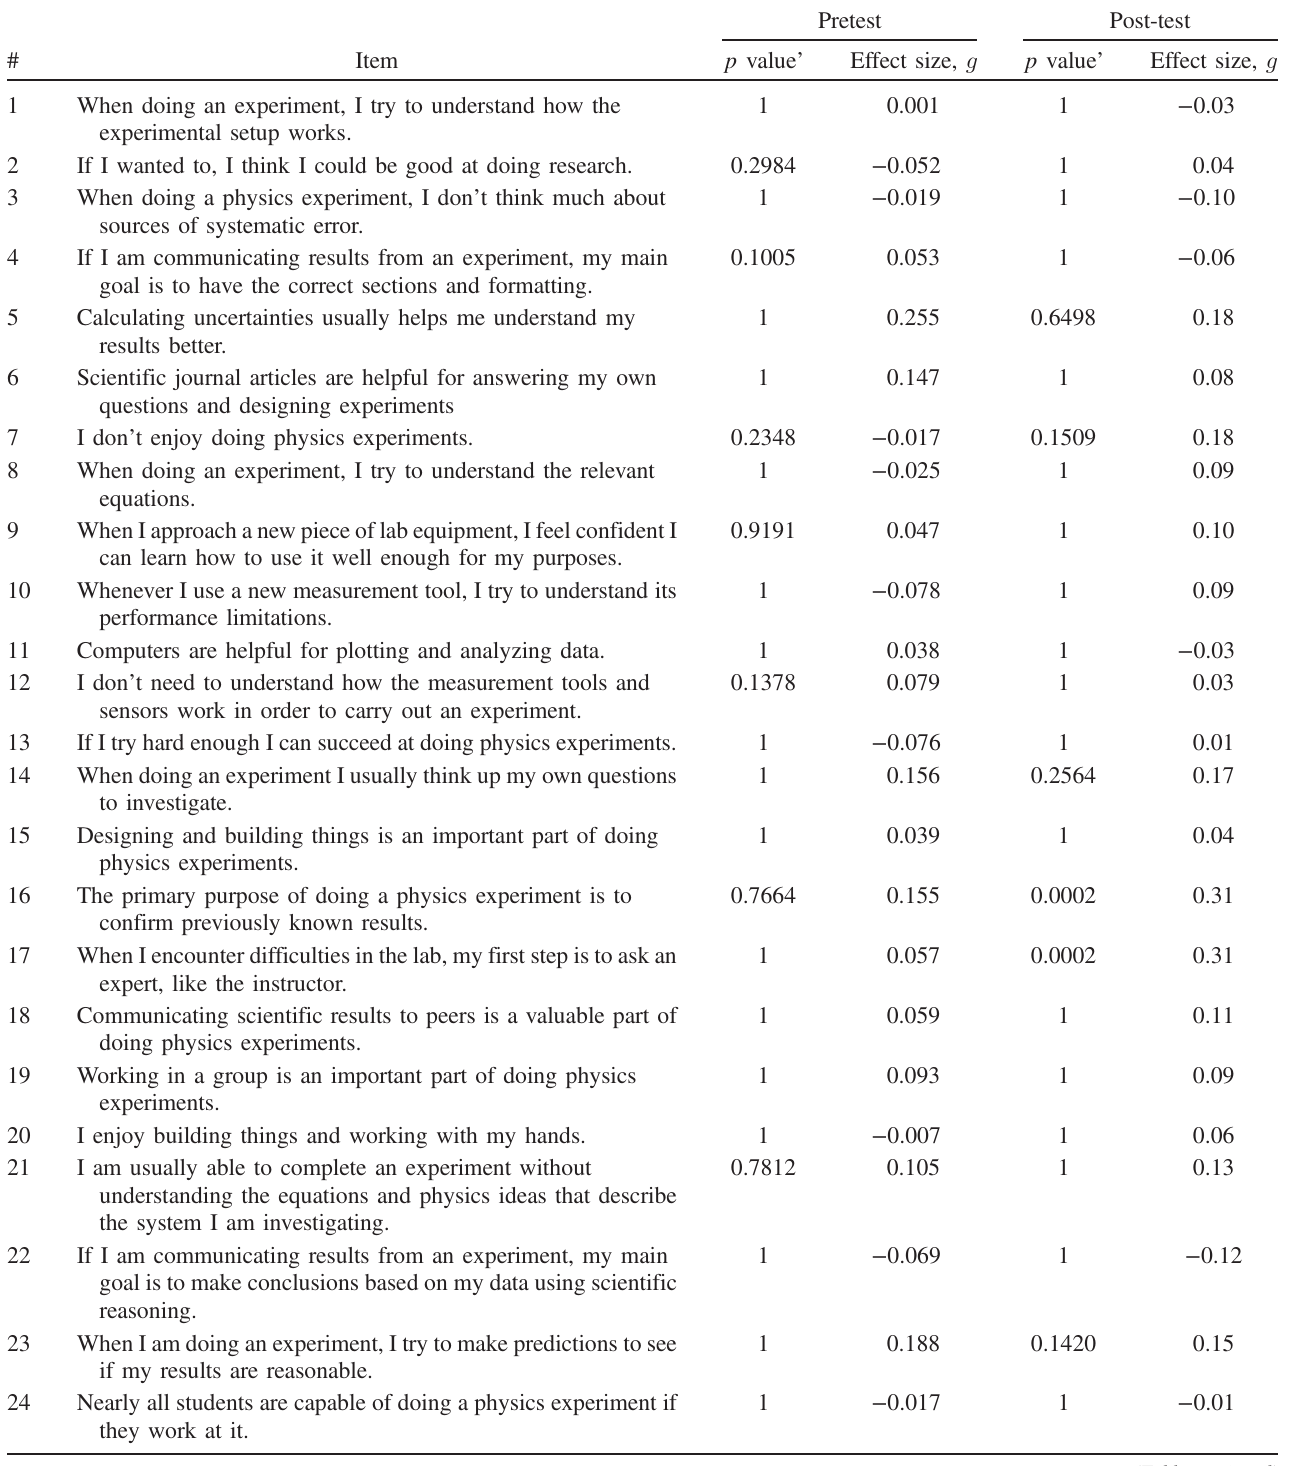
TABLE XII. E-CLASS items on the pretest and post-test compared between BT and AT scores for women using a Mann Whitney U test. The p value has been adjusted using the Holm-Bonferonni correction. A positive effect size, in both pretest and post-test, indicates that the AT course had higher mean scores than the BT course. All effect sizes in this table have Ryan-Holm step-down Bonferroni corrected CI 0 95% ≤ 0 . 21